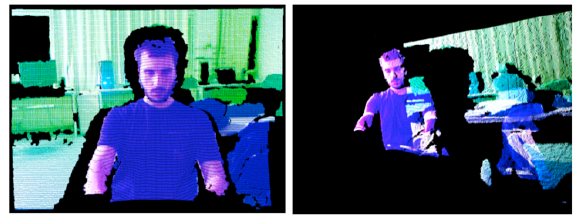
Figure 14 - Front view (left) and lateral (right) Depth Point Cloud Mapping